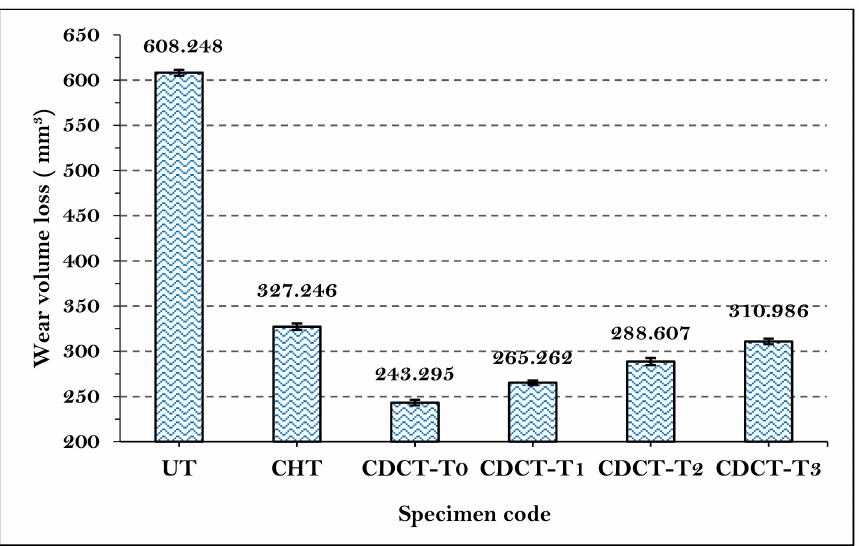
Figure 10. Comparison of abrasive wear loss of untreated and treated